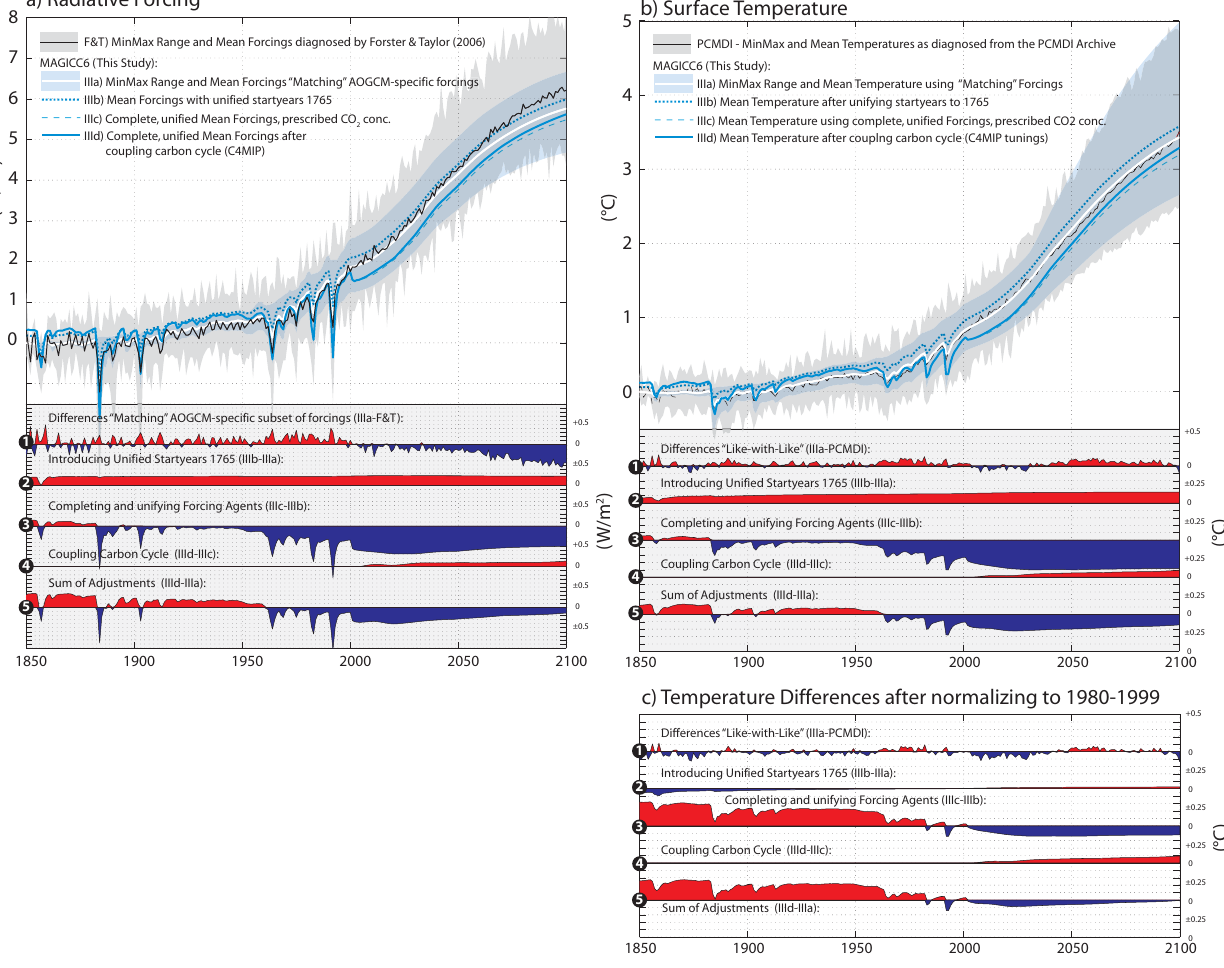
Fig. 1. Net radiative forcing (panel a ) and global-mean surface temperatures (b) for the SRES A1B scenario according to MAGICC6 (calibration III) as presented in this study. For comparison, the radiative forcing applied is compared to the means across all 19 archived CMIP3 AOGCMs, as diagnosed by Forster and Taylor (2006) (F&T, see panel a ). For temperature, the MAGICC6 emulations are compared to the means diagnosed from the matching set of 19 CMIP3 AOGCMs relative to their respective start years. Differences relative to 1980– 1899 are also shown (panel c ). See Table 3 in the companion paper MRW and text for discussion of the different forcing adjustments and temperature effects (black circled numbers). The roman number III denotes the calibration method, while the small latin letters a, b, c, and d denote the forcing assumptions, ranging from (a) AOGCM-specific forcing subsets, (b) forcings relative to a unified 1765 starting year, (c) complete and unified forcings and (d) full forcings including CO 2 concentrations with coupled carbon